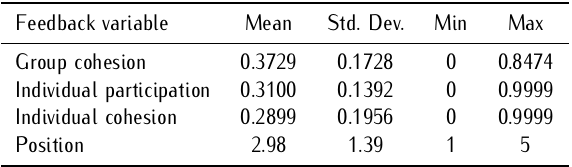
Table 10. Linear model for estimating average pacing by feedback variables and their interactions, controlled by university, skill and country-team size. GC means Group cohesion; IP means Individual participation; IC means individual cohesion; P means Position.